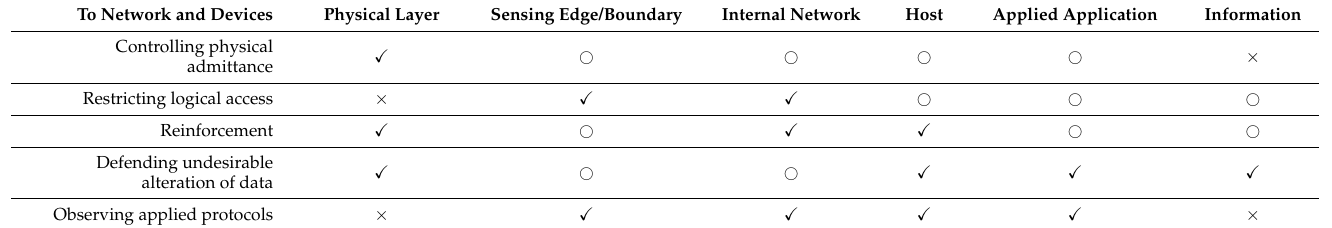
Table 4. Goals achieved by the proposed security steps. (no × ), (yes (cid:88) ), (some-circumstances